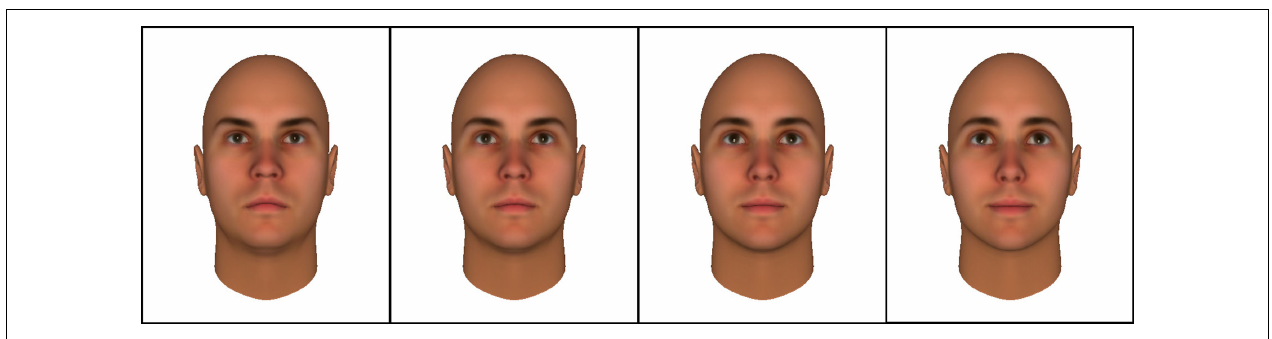
FIGURE 1 | Example of facial stimuli, ranging from “Very untrustworthy” toVery trustworthy (left to right).